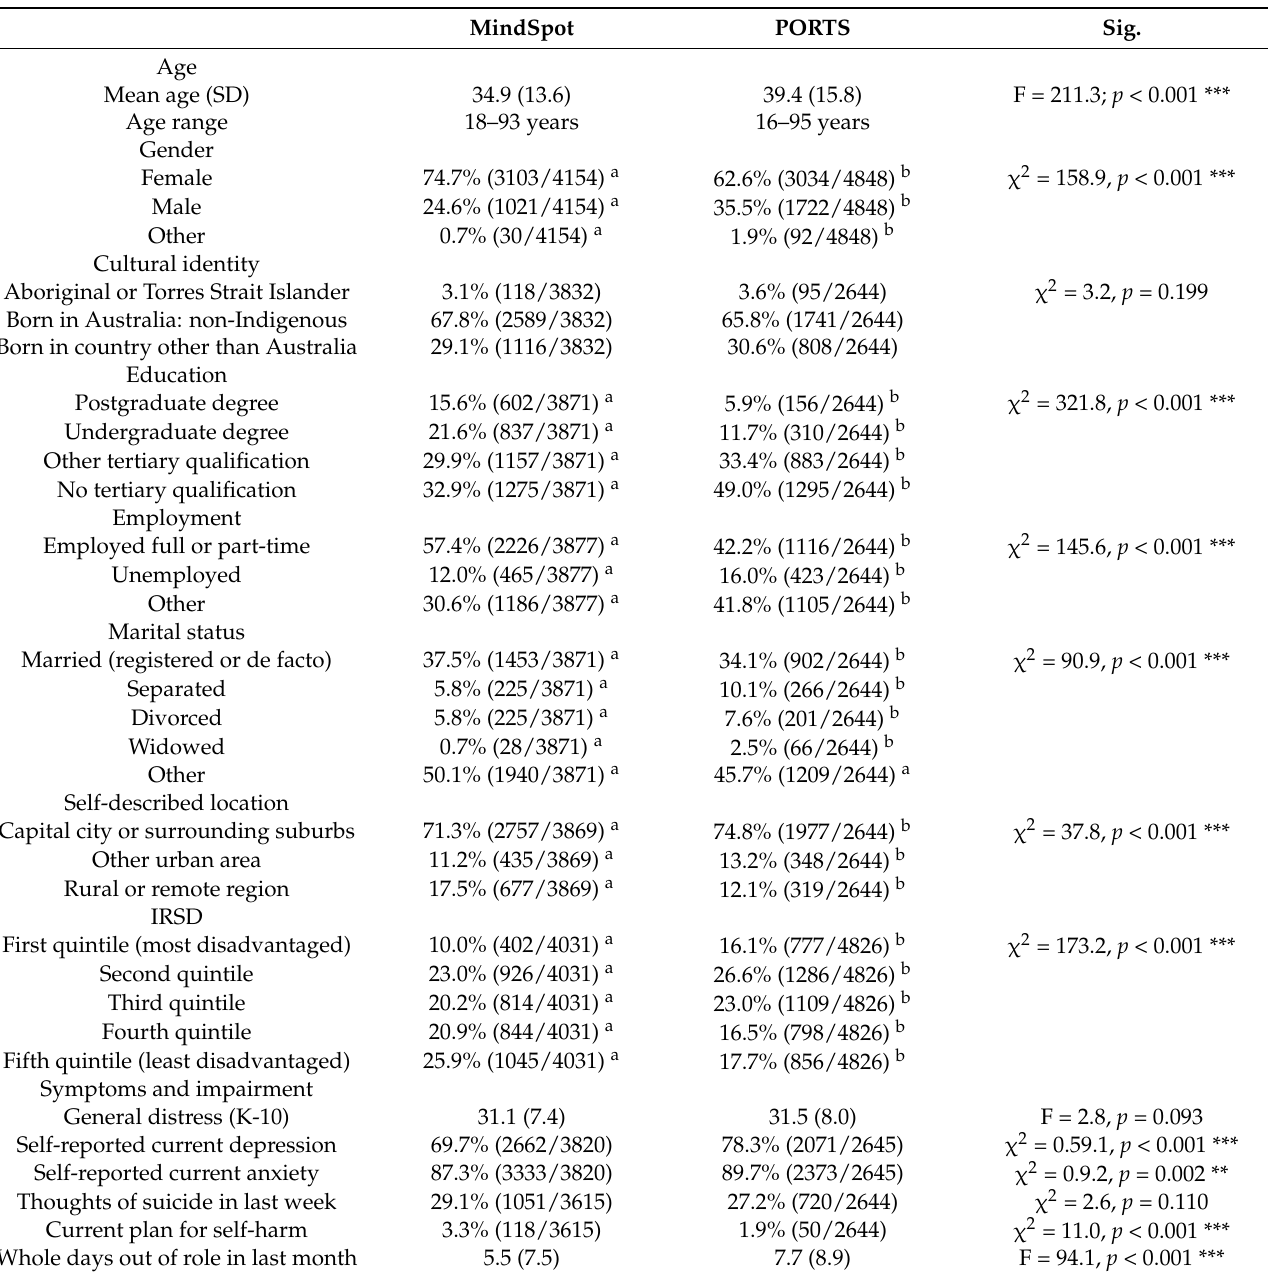
Table 1. Demographic characteristics of patients referred to MindSpot ( n = 4154) and PORTS ( n = 4848). MindSpot